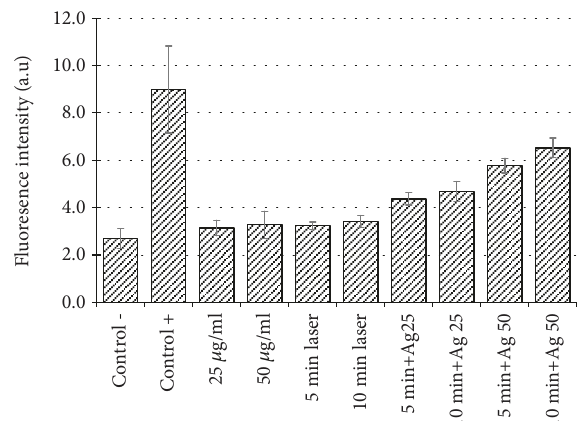
Figure 6: Relative fl uorescence intensity (with respect to H showing the cellular ROS formation following treatment with laser irradiation (5 and 10min), Ag-NPs (25 and 50 mg/ml), or photoirradiated Ag-NPs in E. coli cells compared to negative and positive controls.